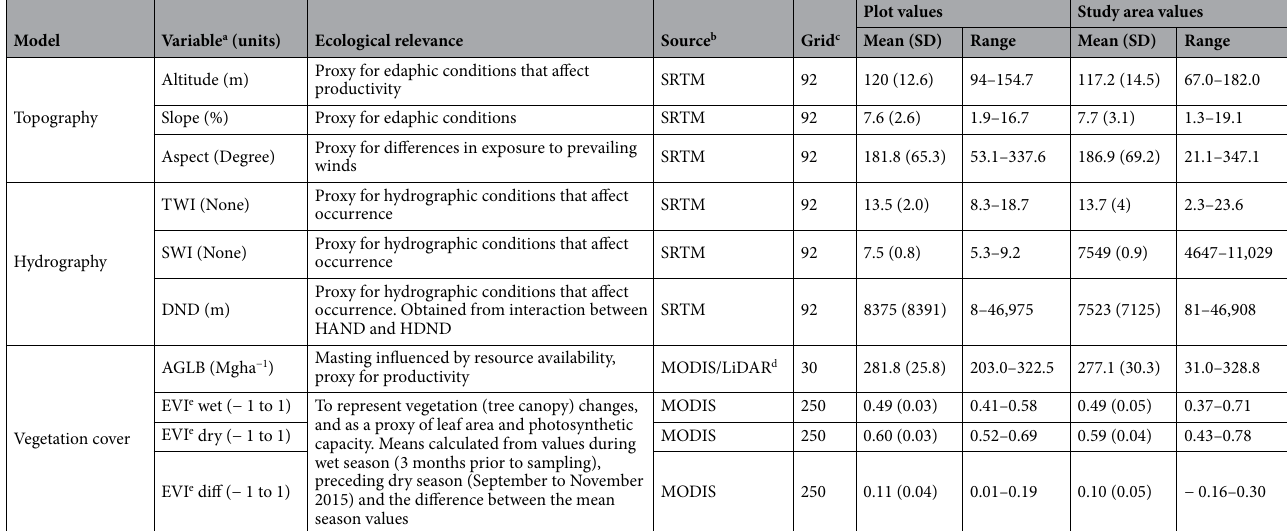
Table 3. Explanatory variables. Summary statistics of variables used to explain patterns in Vouacpoua americana fruit-fall. a Variable acronyms: TWI (Topographic wetness index), SWI (SAGA wetness index), DND (Distance to Network Drainage), HAND (Height above network drainage), HDND (Horizontal distance to network drainage), AGLB (Above ground live biomass), EVI (Enhanced Vegetation Index). b Remote sensed data source. c Native cell resolution (meters) of source raster grid. d Derived from MODIS, imagery using GLAS (Geoscience Laser Altimeter System) LiDAR data, see Baccini et al. 31 for technical details. e Enhanced Vegetation Index 76,77 . Area with less leaf area (less green) during the preceding dry season could have increased flowering and therefore increased masting fruit-fall in the wet